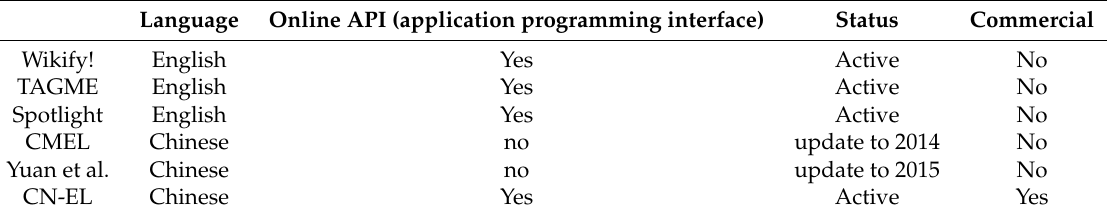
Table 1. Summary of entity extraction